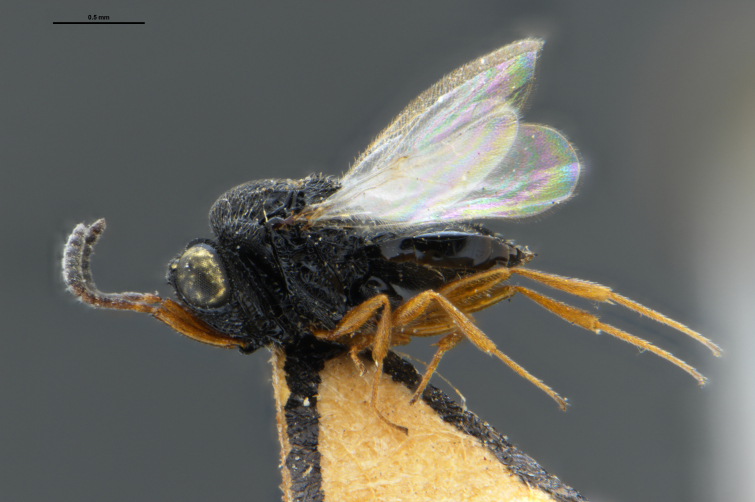
lateral habitus